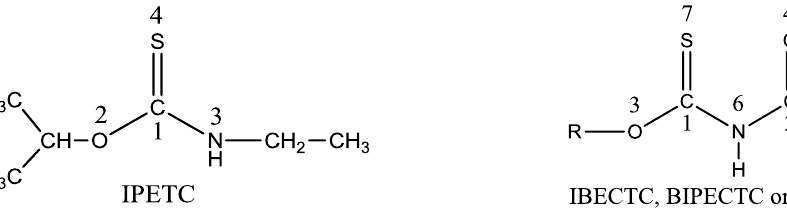
Figure 15. Atom numbers in the functional groups of IPETC, IBECTC, BIPECTC and BMIPECTC.